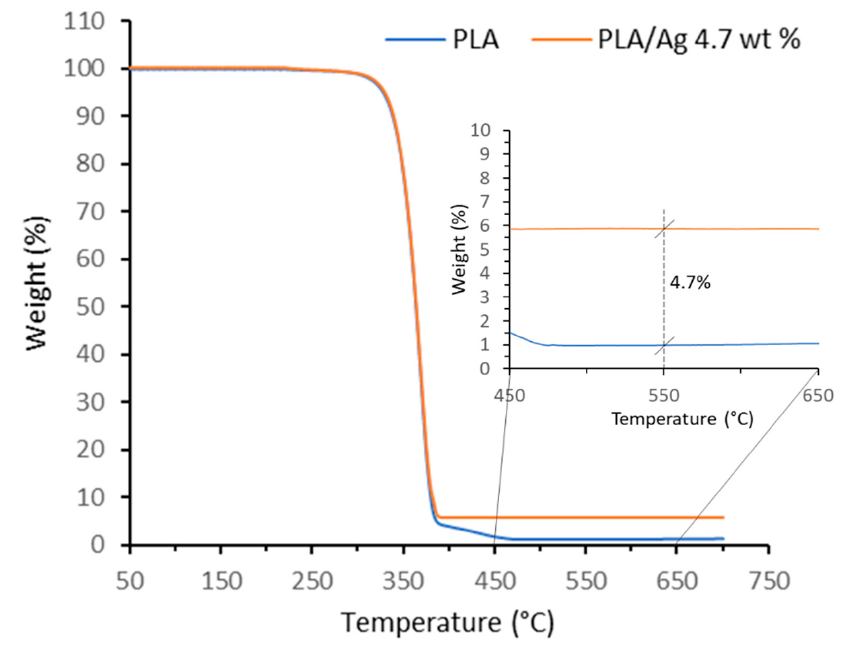
Figure 4. Thermogravimetric degradation curves of PLA and AgNPs/PLA mats.